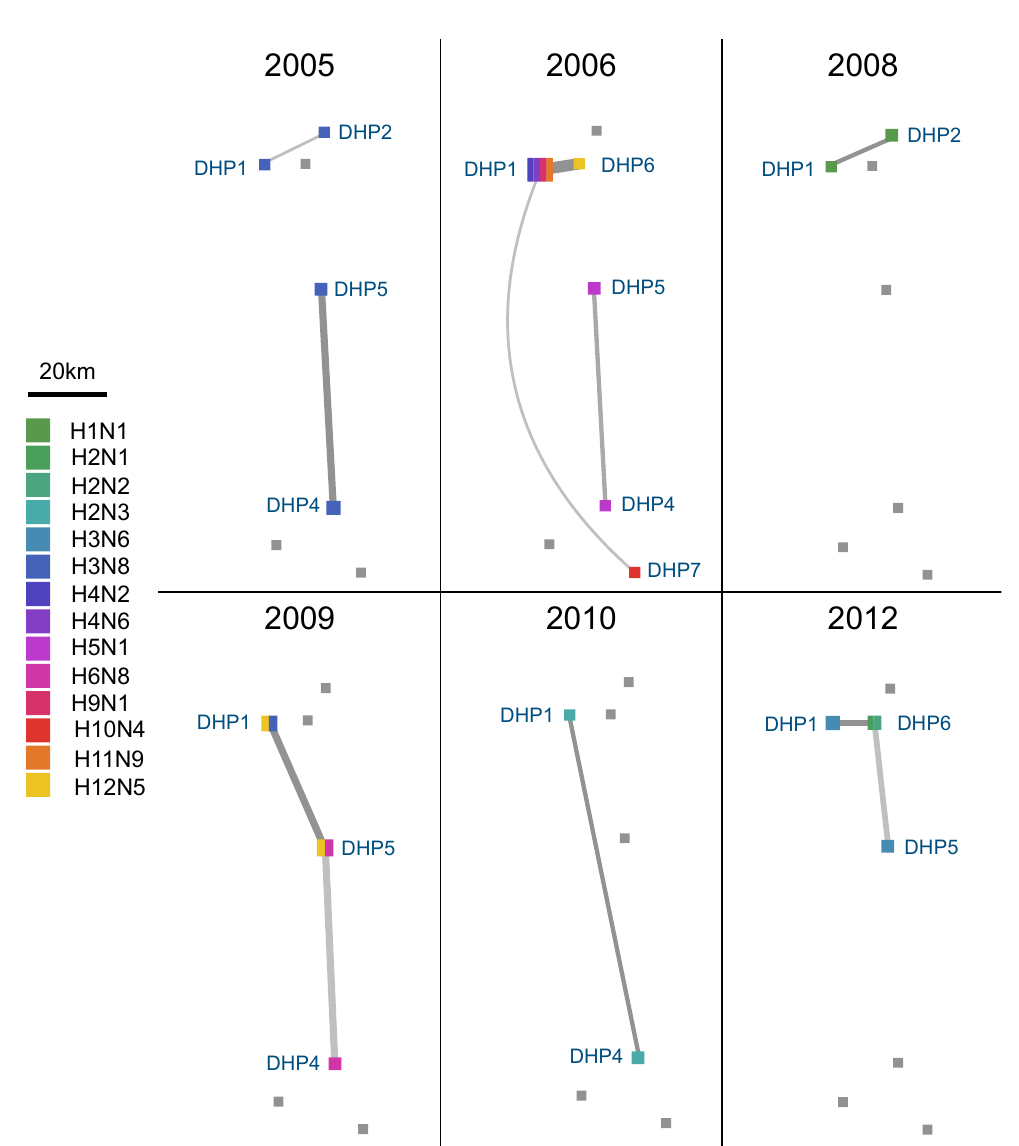
Figure 6. Viral connectivity map between DHPs. Lines represent inferred viral movements between genetically similar IAVs collected from DHPs that clustered together in the same monophyletic clade in the PB2 MCC tree. Line thickness is proportional to the number of viruses in the monophyletic clade. Squares represent DHPs, where size is proportional to the number of viruses for each DHP, and color represents the subtypes circulating in the DHP. Distances between DHPs on the map are proportional to real-world distances.